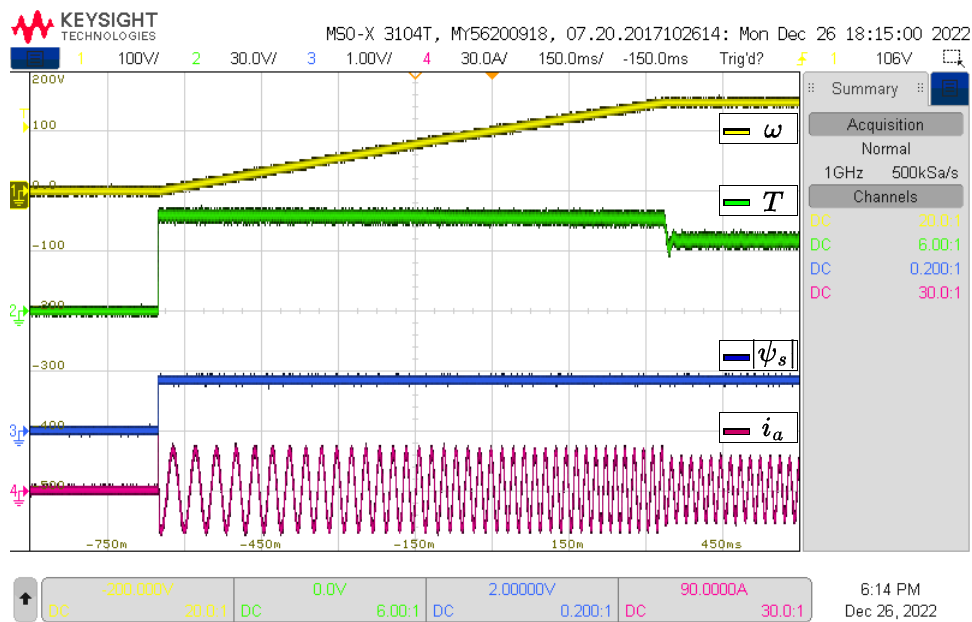
Figure 10. HIL Results for VSI with N = 2.